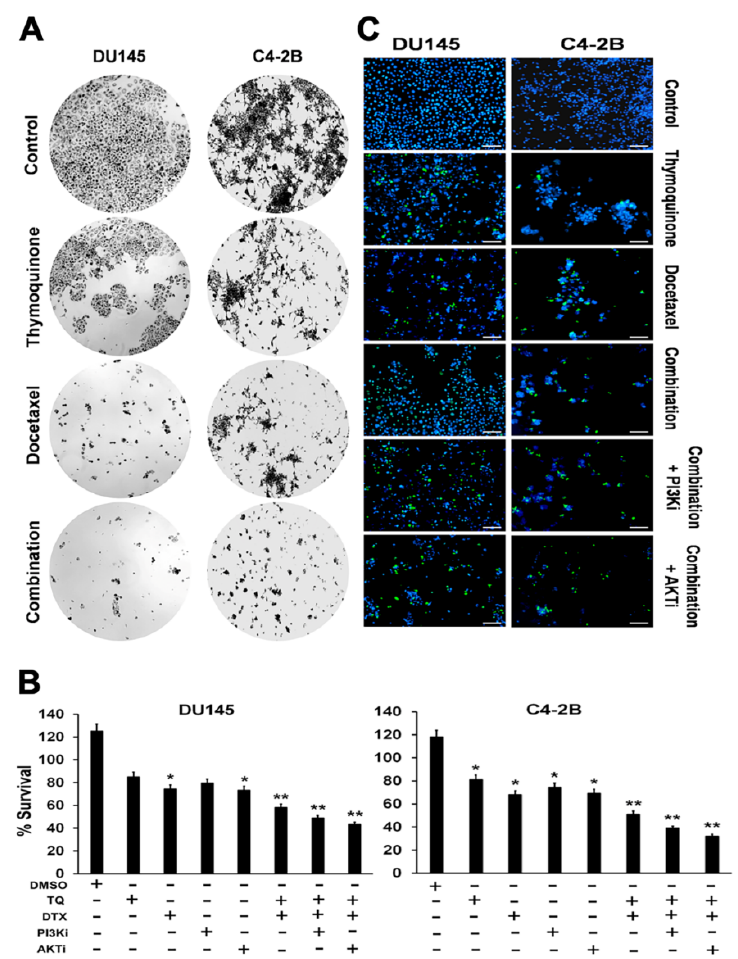
Figure 1. E ff ect of TQ and DTX on cell viability and cytotoxicity to PCa cells. PCa cells were treated with sequential concentrations of TQ, DTX, or a combination of TQ and DTX for 48 h, and viability was measured by MTT assays for ( A ) DU145 and C4-2B cells. DU145 cells were treated with TQ (60 µ M), DTX (20 nM), or their combination (TQ + DTX, 50 µ M + 10 nM); C4-2B cells were treated with TQ (54 µ M), DTX (20 nM), or their combination (TQ + DTX, 35 µ M + 10 nM) for 48 h. ( B ) shows the percentage survival of DU145 and C4-2B cells after treatment with TQ, DTX, PI3Ki, AKTi or their combination with or without PI3Ki (1.4 µ M) and AKTi (625 nM) for 48 h. Sign “ + or − “ represents the presence or absence of the drugs. Data are presented as means ± standard error of the means of at least three independent experiments and were analyzed by an unpaired t-test. ** and * indicate p values of ≤ 0.01 and 0.05, respectively. ( C ) shows the DU145 and C4-2B cells treated with TQ, DTX, or their combination with or without PI3Ki and AKTi for 48 h and were processed for immunofluorescent staining. More live nuclei (blue) were found in the control group compared to any of the treatment groups. More dead nuclei (green) were found in those treated with the combination in presence or absence of PI3Ki and AKTi compared to treatment with individual drugs. Nuclei of live and dead cells, detected by DAPI staining and a GFP filter, appear as blue or green, respectively.